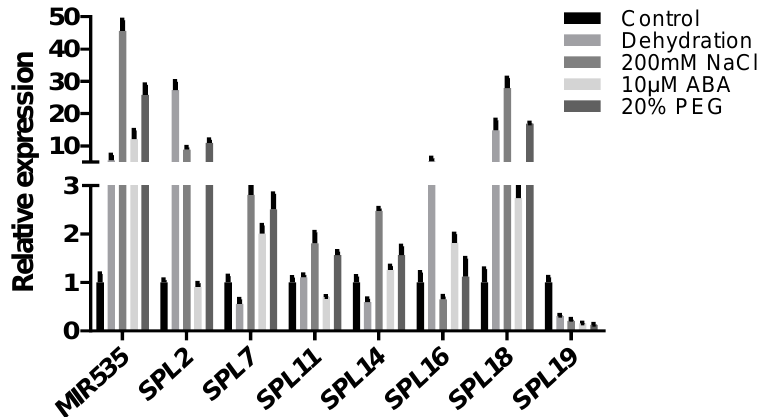
Figure 1. Expression of OsmiR535 and OsSPL2 / 7 / 11 / 14 / 16 / 18 / 19 in seedlings under hormone and stress treatments, including dehydration, 200 mM NaCl, 10 µ M ABA and 20% PEG. Six seedlings were tested in each treatment, each treatment had 3 replicates, error bars represent the standard deviation (SD). Rice UBIQUITIN ( Os03g0234200 ) was used as a reference gene.